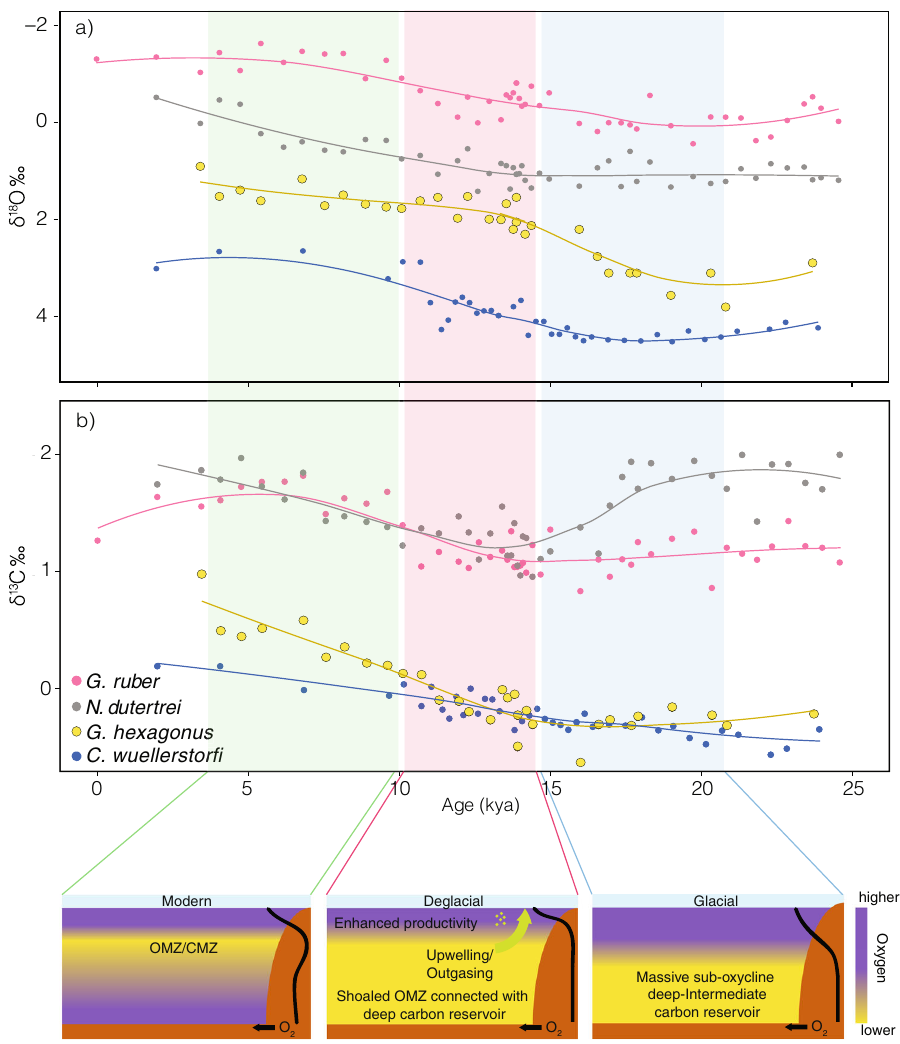
Fig. 3 Stable isotope values with time for TR163-23. The a δ 18 O records from G. ruber (pink), N. dutertrei (gray), G. hexagonus (yellow), and C. wuellerstor fi (blue) and b δ 13 C records from G. ruber (pink), N. dutertrei (gray), G. hexagonus (yellow), and C. wuellerstor fi (blue) are shown with a loess curve fi t through each record. Below are schematic reconstructions of water column oxygen in the Holocene, deglacial interval, and late glacial/early deglacial interval. Data for G. hexagonus is supplemented with data from 14,37 . Species are ordered in the key by habitat depth. Measurement error is 0.05 ‰ for δ 18 O and 0.03 ‰ for δ 13 C, which is smaller than the points